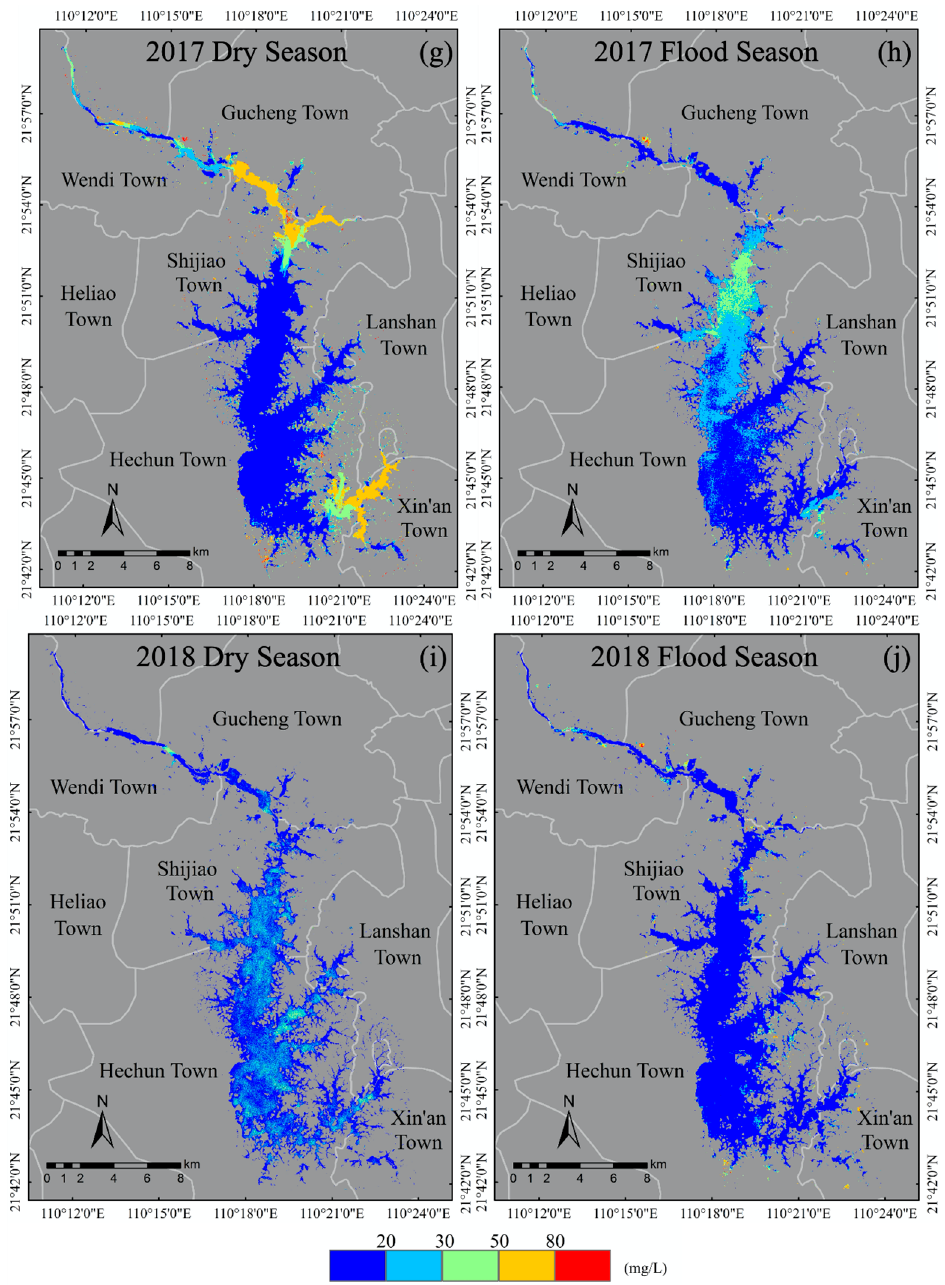
Figure 7. The spatial distribution map for the estimated concentration of TSS on an annual average in dry and flood seasons of Hedi Reservoir from 2014 to 2018 is mapped as shown in the figure, among which ( a , c , e , g , i ) are in the dry season within 5 years, and the rest ( b , d , f , h , j ) fall into the flood season. The color scale is the legend of the average TSS concentrations, in mg/L.